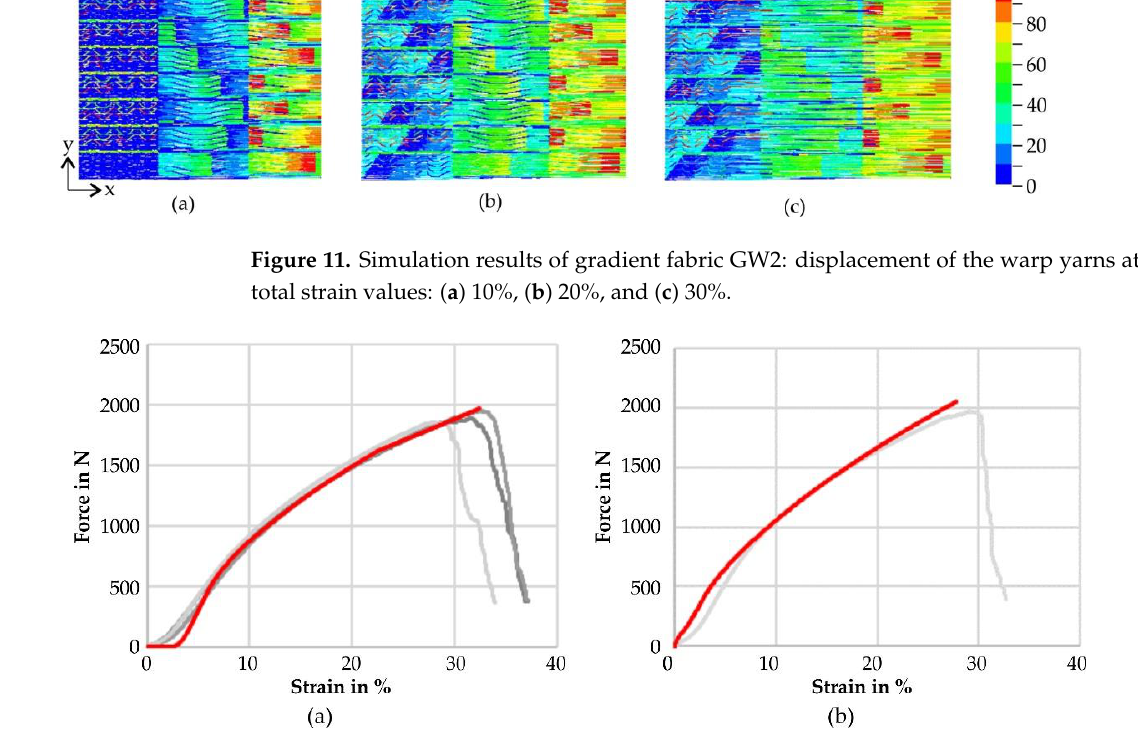
Figure 12. Experimental (grey) and simulated (red) force-strain curves of ( a ) GW1 and ( b ) GW2.